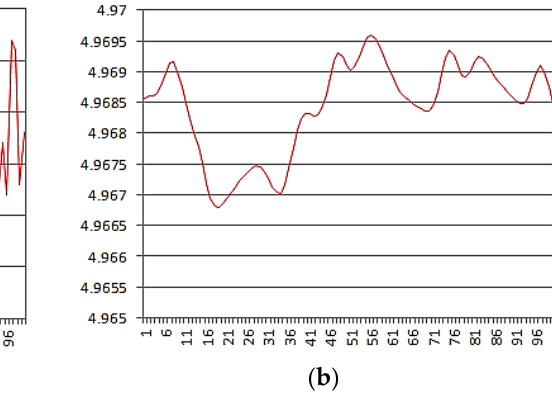
Figure 12. ( a ) Raw data; ( b ) Filtered data.